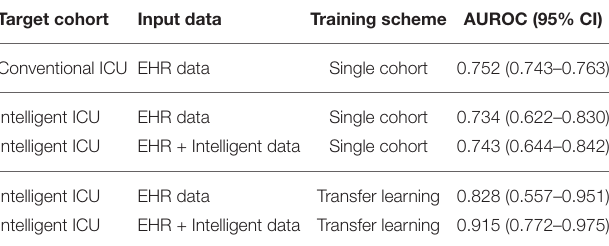
TABLE 3 | Hospital discharge prediction results for all experimental